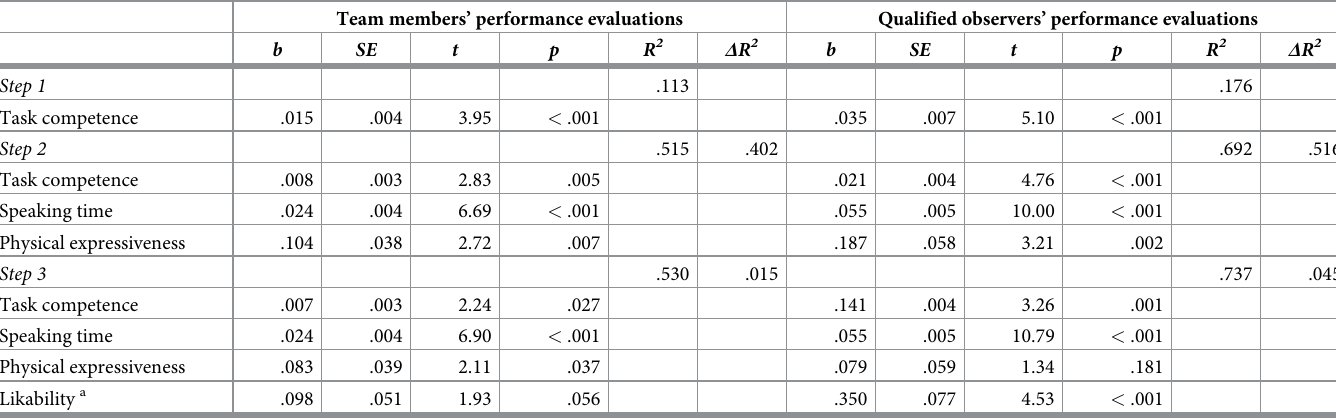
Table 2. Hierarchical fixed effects regression analyses.